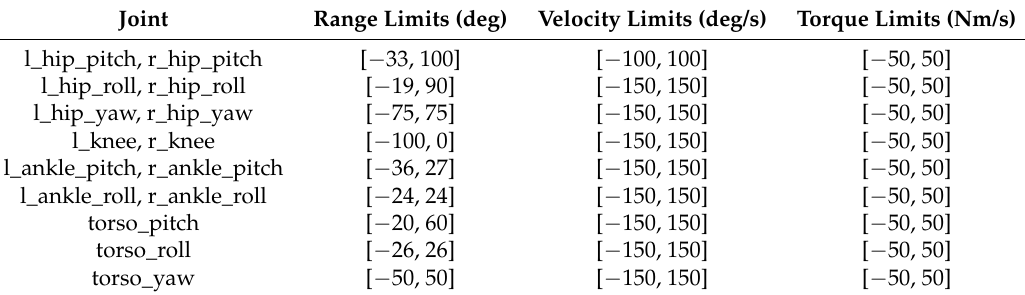
Table 1. HeiCub joint